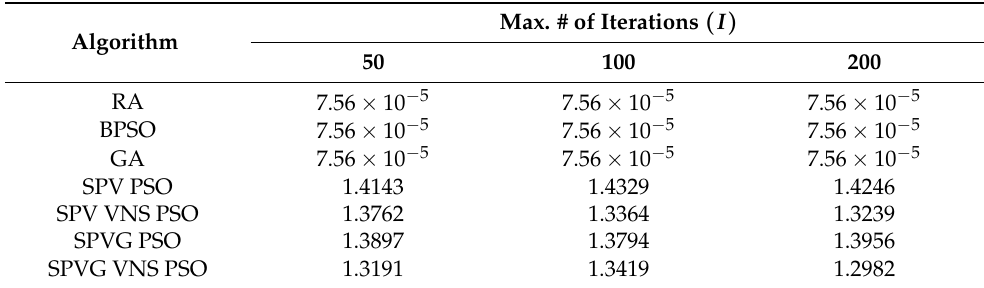
Table 4. Minimal spectral efficiency (in bps/Hz) using the optimal parameters for each heuristic